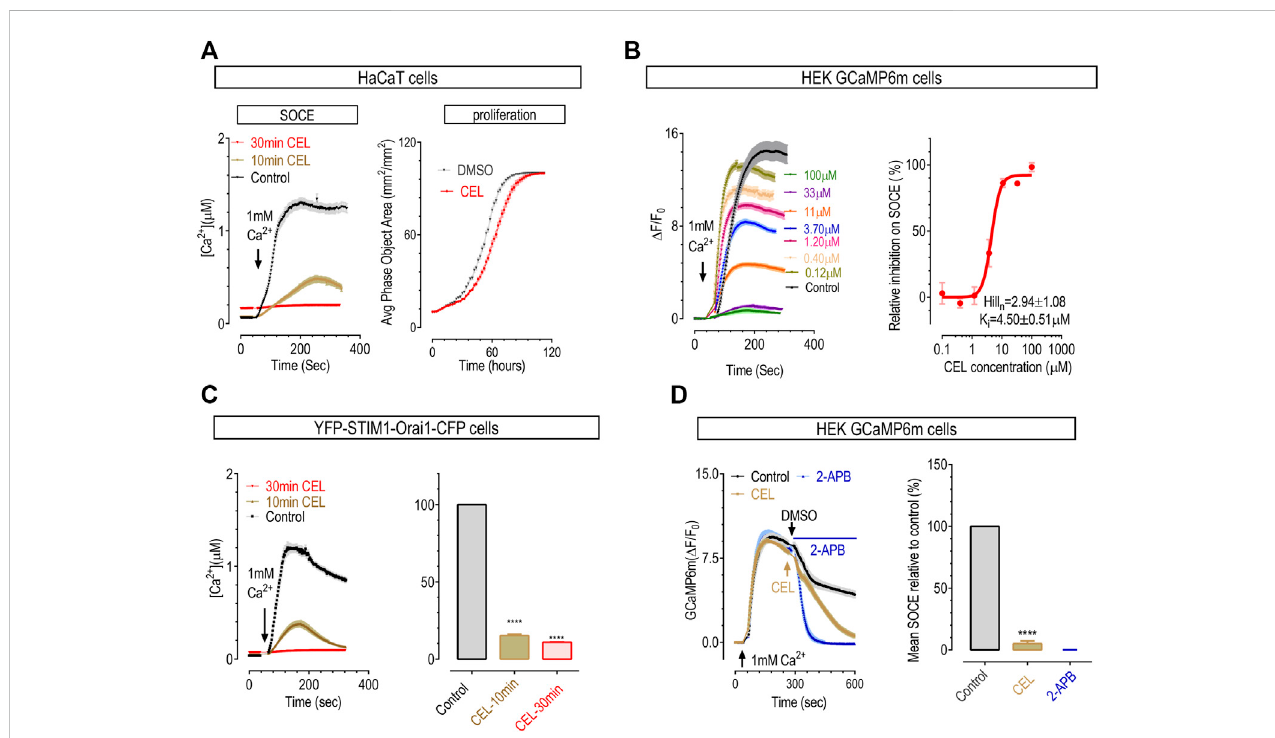
Celastrol dose- and time-dependently inhibited SOCE in HaCaT cells and HEK cells. To empty ER Ca 2+ stores, prior to recordings, cells were fi rst treated with 1 μ M TG in Ca 2+ free solution for 10 min. (A) The effect of pre-incubation of celastrol on SOCE and proliferation of HaCaT cells. Left, typical SOCE traces (50 μ M); right,representative proliferation curves (3 μ M).Doubling time: control,18.9±0.2 h; celastrol, 21.3 ±0.3 h( t -test,****, p < 0.0001, n =3). (B) Effects of10-minpre-incubationofcelastrolonSOCEinHEK-GCaMP6m cells.Left,representativetraces;right,doseresponsecurves. (C) Actionofcelastrolon SOCE in HEK STIM1-Orai1 overexpressing cells. Prior to imaging, cells were pretreated 10 min (yellow), 30 min (red) with 50 μ M celastrol or DMSO (black). Left, Typical traces; right, Statistics ( t -test, ****, p < 0.0001, n = 3). (D) Effects of acute application of 50 μ M celastrol on SOCE in HEK GCaMP6m cells. Effects of 50 μ M 2-APB were used as a positive control. Left, Typical traces; right, Statistics ( t -test, ***, p < 0.0001, n =